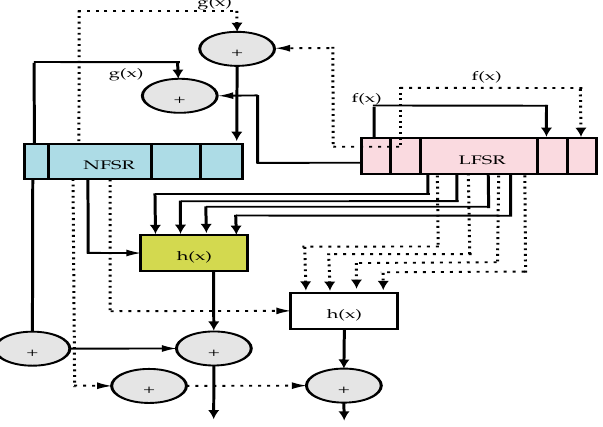
Figure 7. Doubling-speed Grain